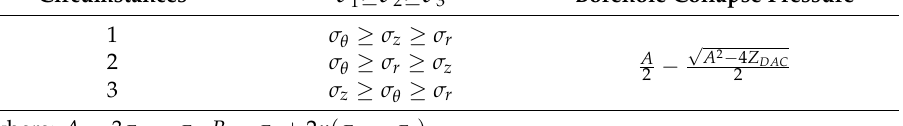
√ D 2 − 4 Z DAF D + 2 2 (cid:104) (cid:16) (cid:17)(cid:105) 1 − 10.5 × 10 − 3 − 1 T 273